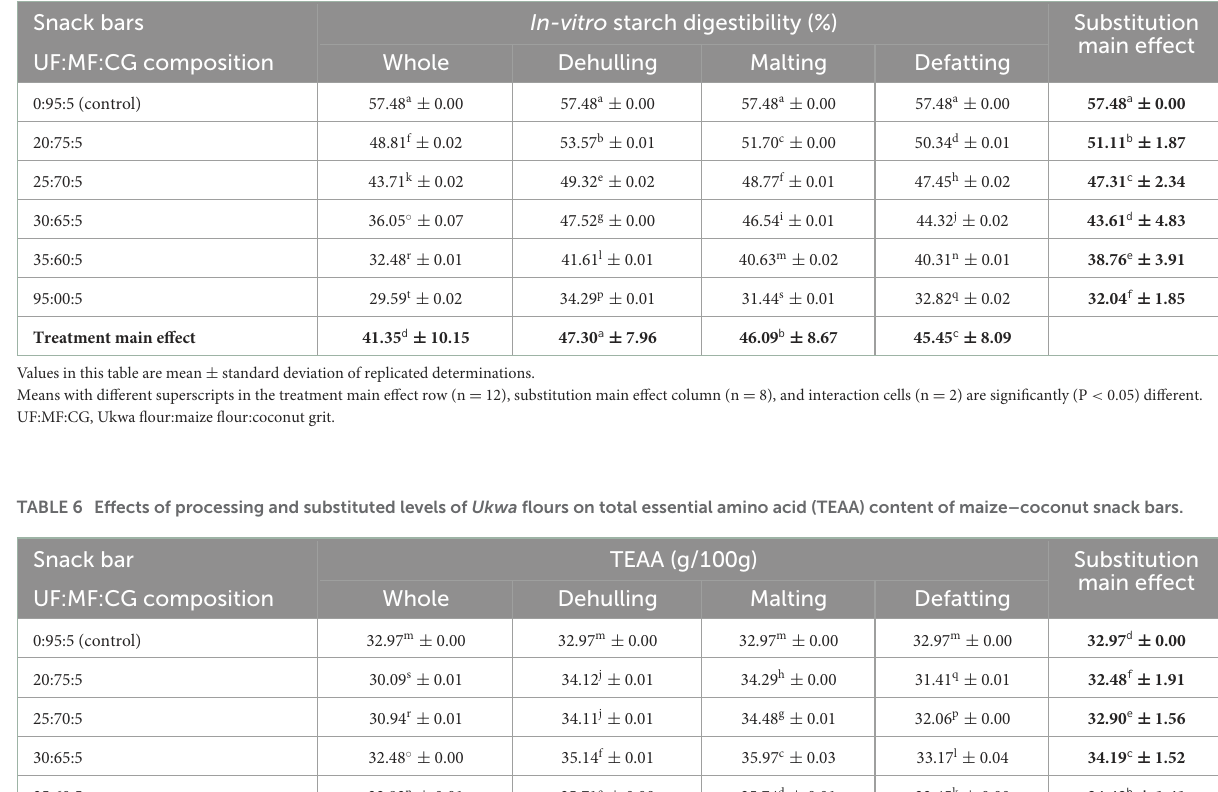
TABLE 5 Effect of processing and substituted levels of Ukwa flours on the in vitro starch digestibility of maize–coconut snack bars. Snack bars In-vitro starch digestibility (%) Substitution UF:MF:CG composition Whole Dehulling Malting